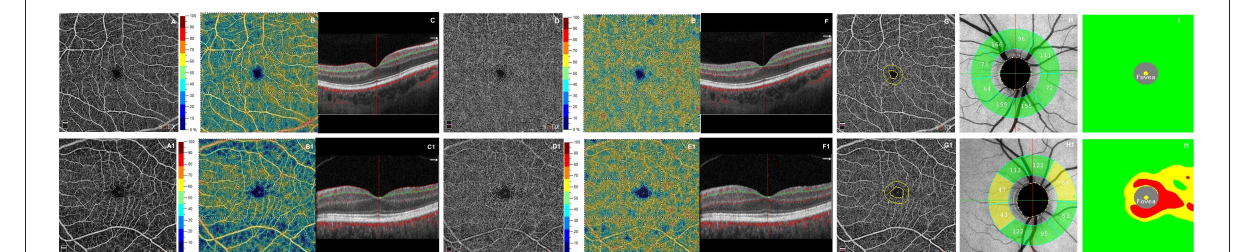
FIGURE1 First row shows optical coherence tomography angiography (OCTA) images from a healthy subject’s right eye (male, 30 years): normal superficial and deep capillary plexuses in terms of retinal vasculature texture (A,D) and in vessel density (B,E) . The OCT B-scan (C,F) shows normal retinal profile, thickness. The foveal avascular zone (FAZ) shows a normal size of the area (G) . Structural OCT reveals normal thicknesses of retinal nerve fiber layer (RNFL) (H) and ganglion cell complex (GCC) (I) . The second row shows a patient’s right eye (female, 31 years) affected by relapsing-remitting multiple sclerosis. OCTA images show in superficial capillary plexus a rarefaction in vascular texture (A1) and in vessel density (B1) . The deep capillary plexus reveals focal rarefactions in terms of retinal vasculature texture (D1) and in vessel density (E1) . The OCT B-scan (C1, F1) shows a normal retinal profile and thickness. The foveal avascular zone (FAZ) shows an evident enlargement of the area (G1) . Structural OCT reveals several zones of reduced thicknesses of RNFL and GCC respect to healthy subject (H1, I1)